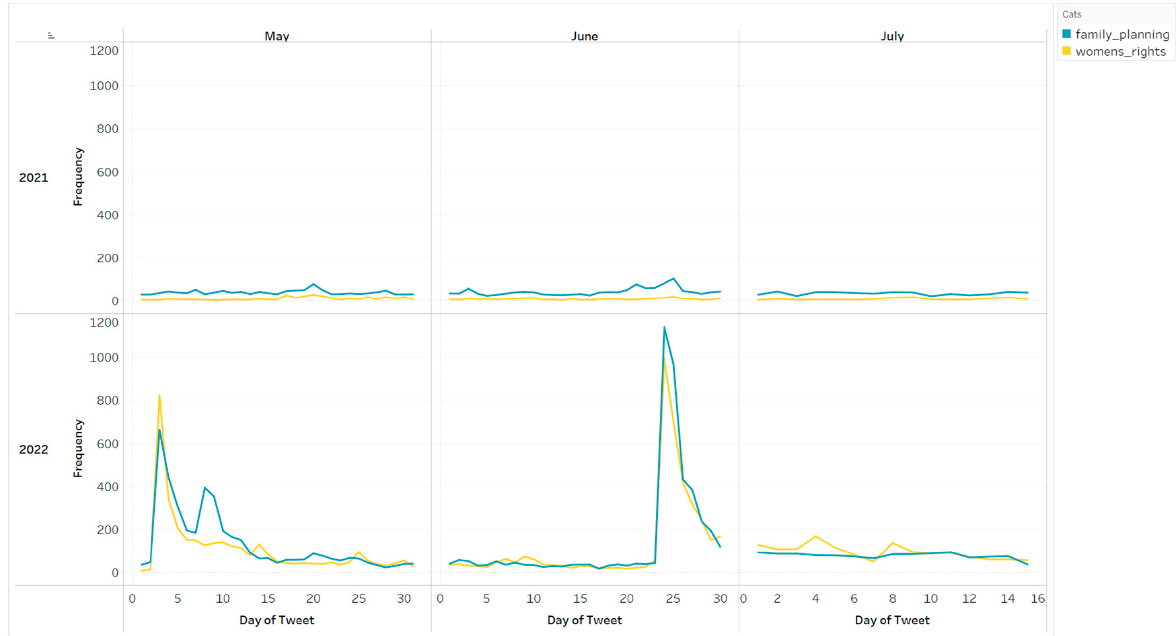
Figure A4. Number of Tweets about Abortion, Roe v Wade, and Women from 1 May–15 July in 2021 and 2022.